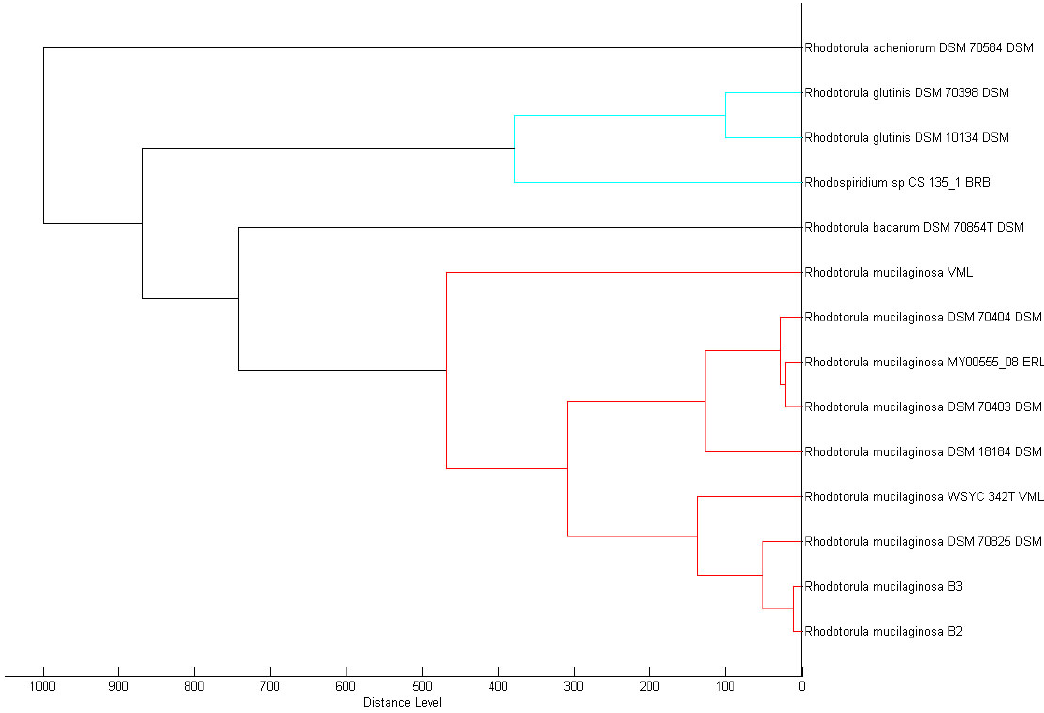
Figure 1. Dendrogram of isolates B2 and B3. Identification of isolates B2 and B3 was analysed using MALDI-TOF-MS and data were presented as dendrogram which indicates these isolates are identified as Rh . mucilaginosa